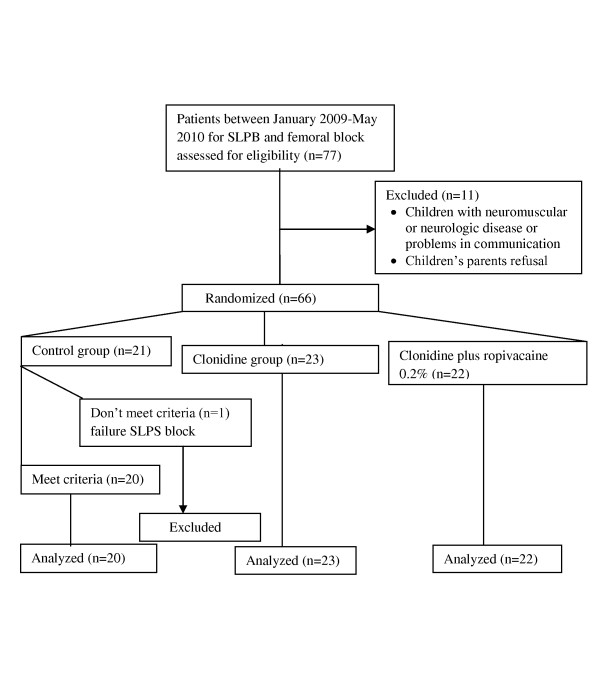
Flow diagram of the study.